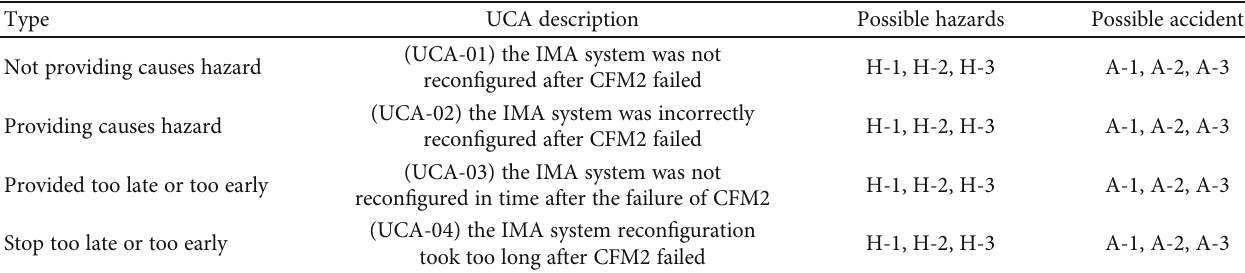
Table 2: Unsafe control